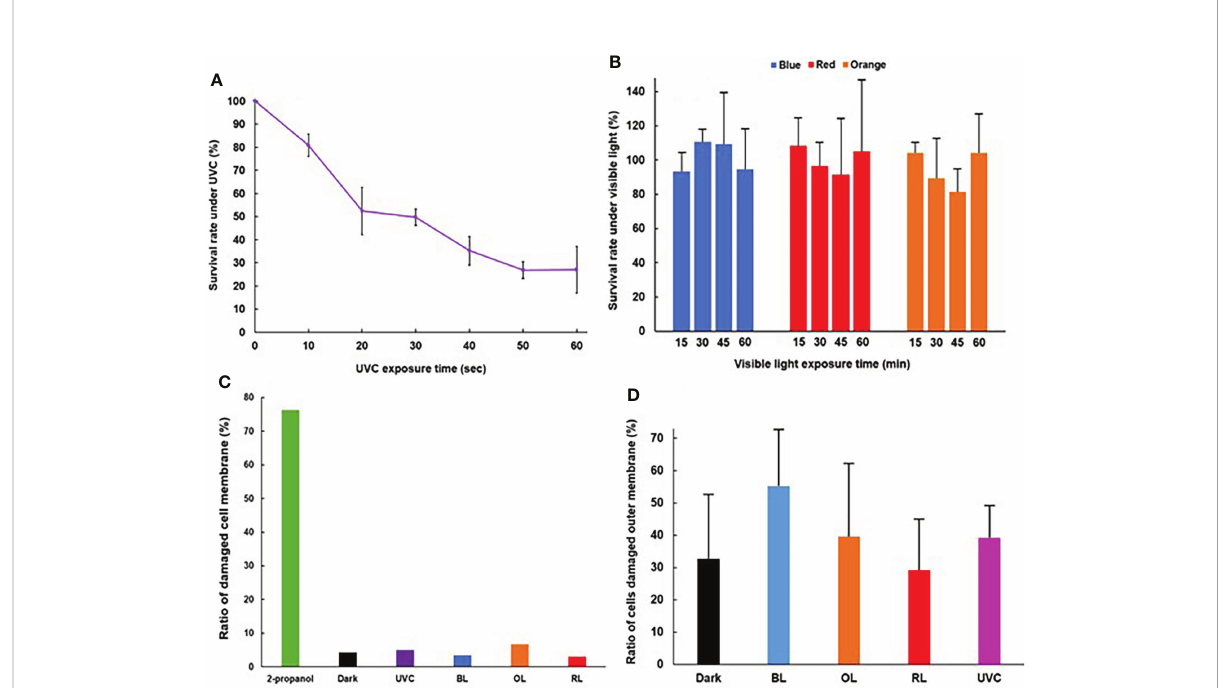
FIGURE 1 Survival rate and cell damages of Vibrio parahaemolyticus after exposure of various lights. (A) Time course of survival rate after UVC exposure. UVC dose was set at 60 m W/cm 2 . ( N = 3, mean ± standard deviation). (B) Time course of survival rate after BL, RL, and OL exposures. Photon fl ux density was set at 50 µmoles/m 2 /s. ( N = 3, mean ± standard deviation). (C) Cell membrane damage. (D) Outer membrane damage ( N = 3, mean ± standard deviation). For (B, D) , no statistical signi fi cance was